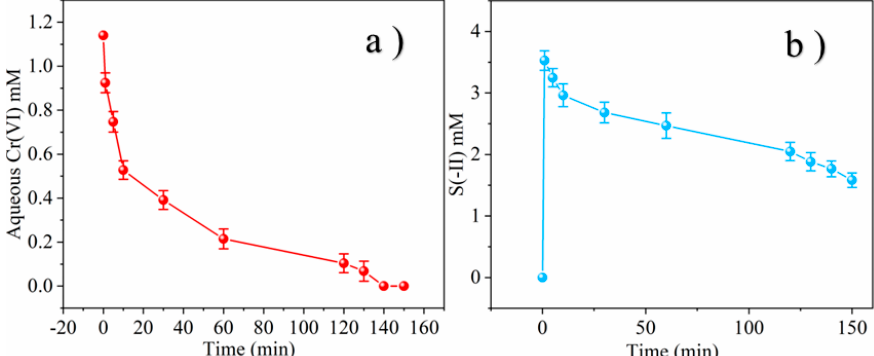
Figure 7. Removal of Cr(VI) by SRB bacteria alone. ( a ): Cr (VI) removal action, ( b ): change in concentration of S(-II) in solution. Reaction conditions: Fe(II) dosage concentration was 0 mM; Cr(VI) dosing concentration was 1.14 mM; the initial pH of the reaction was 5.0; the reaction time was 2 h; and the speed was 200 rpm. Data were plotted as means of duplicates, and the error bars indicate the standard deviation.